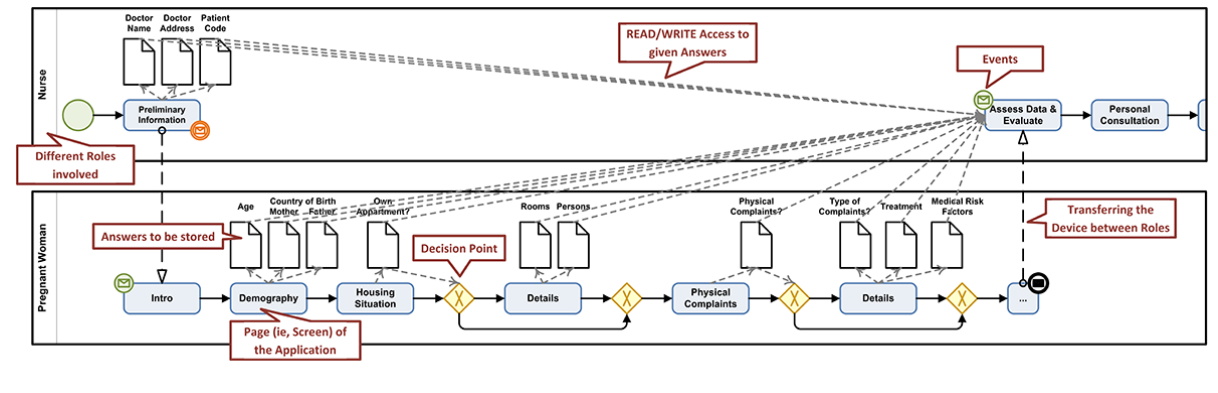
Figure 1. A data collection instrument represented as BPMN 2.0